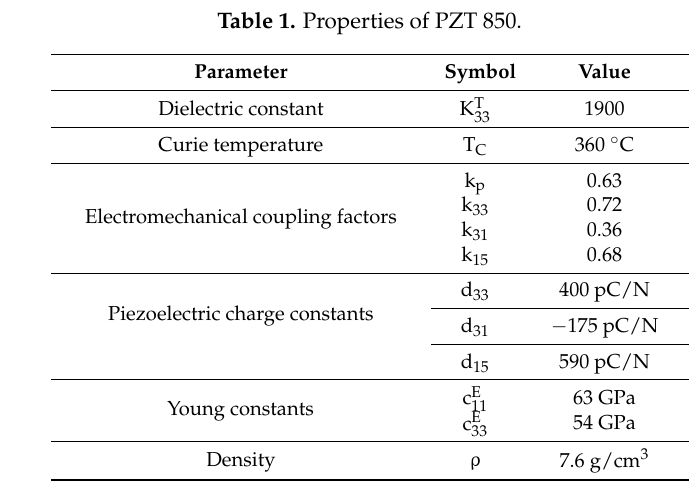
Table 1. Properties of PZT 850.